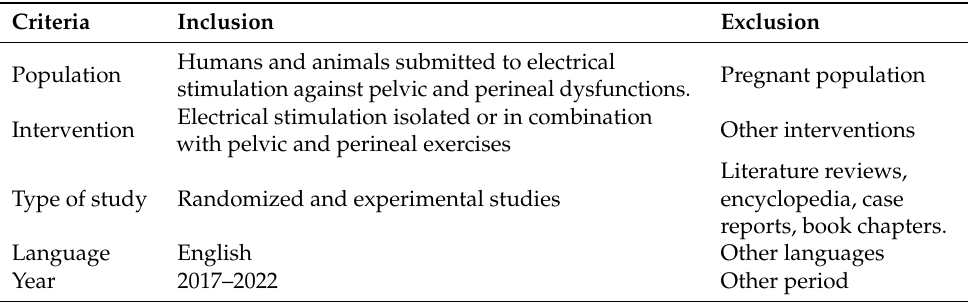
Table 1. Inclusion and exclusion criteria of the